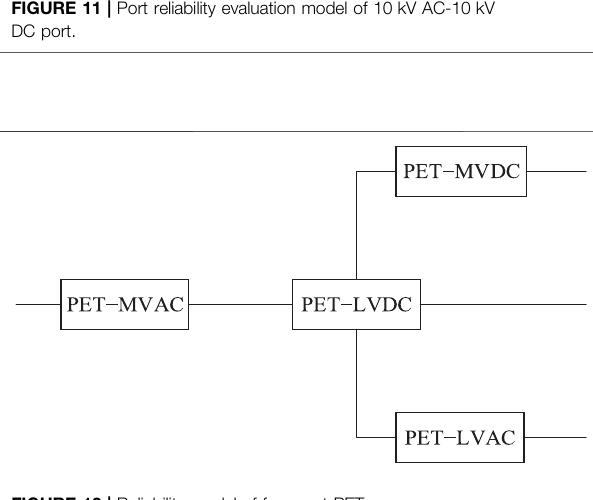
FIGURE 12 | Reliability model of four-port PET.